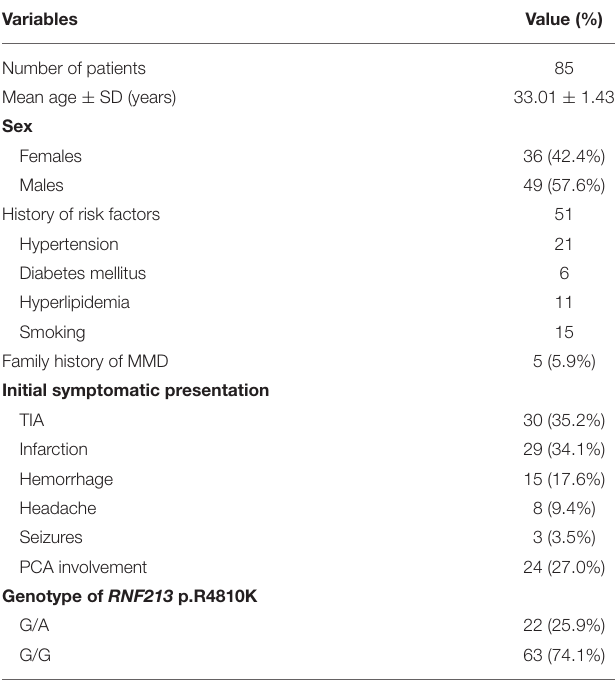
TABLE 1 | Demographic data of the 85 bilateral MMD